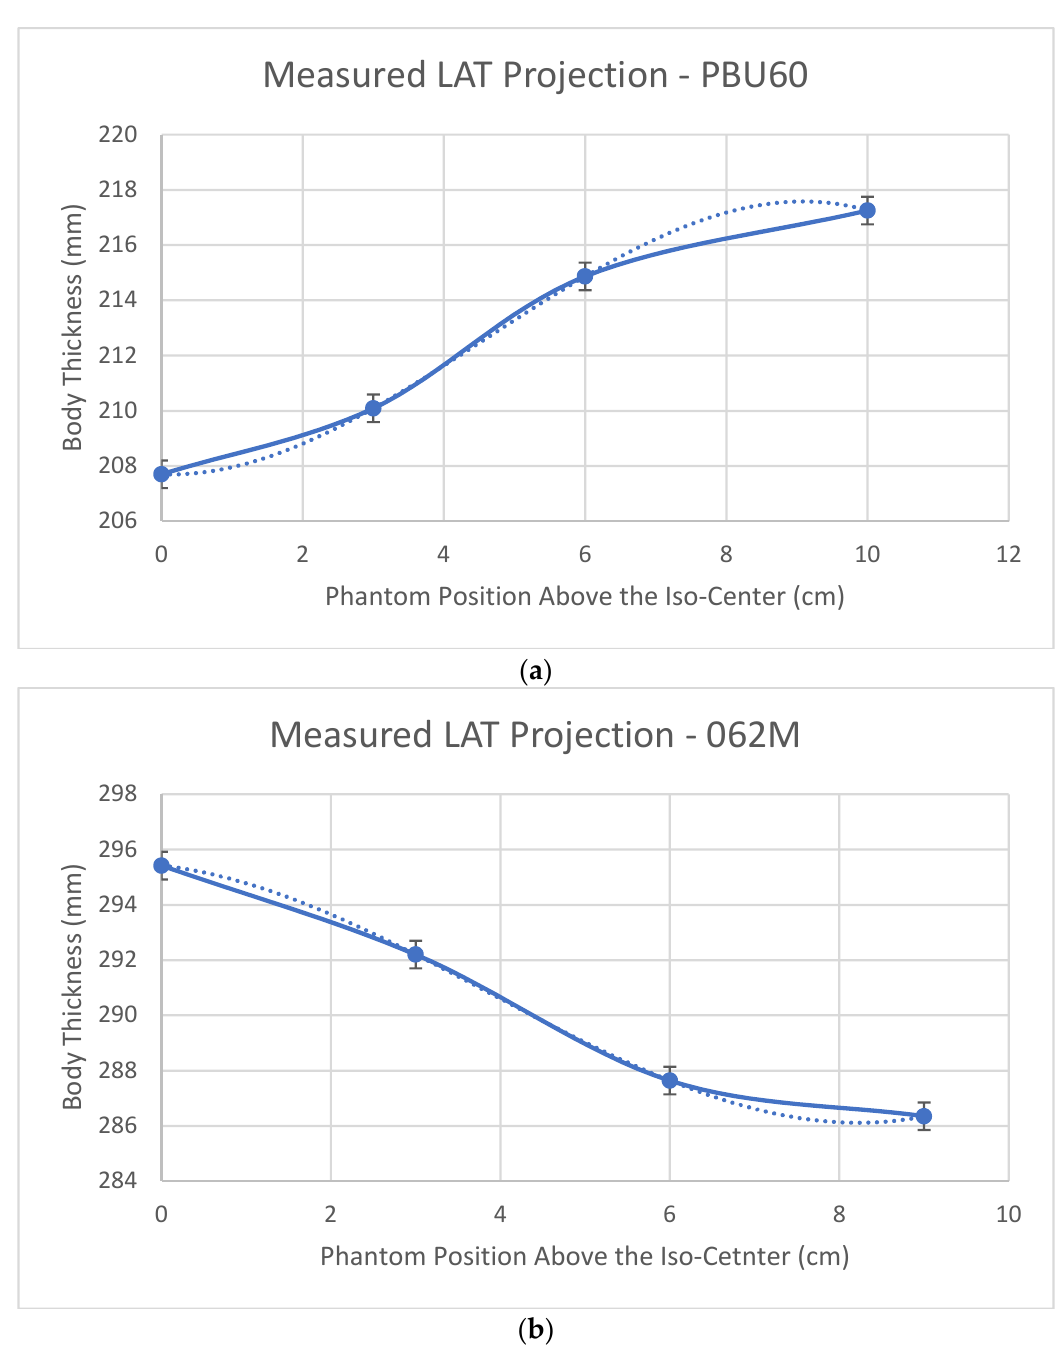
Figure 5. Body thickness measured from the SPR images using a LAT localizer: ( a ) the PBU60 phantom using the HD750 scanner and ( b ) the 062M phantom using the APEX scanner.